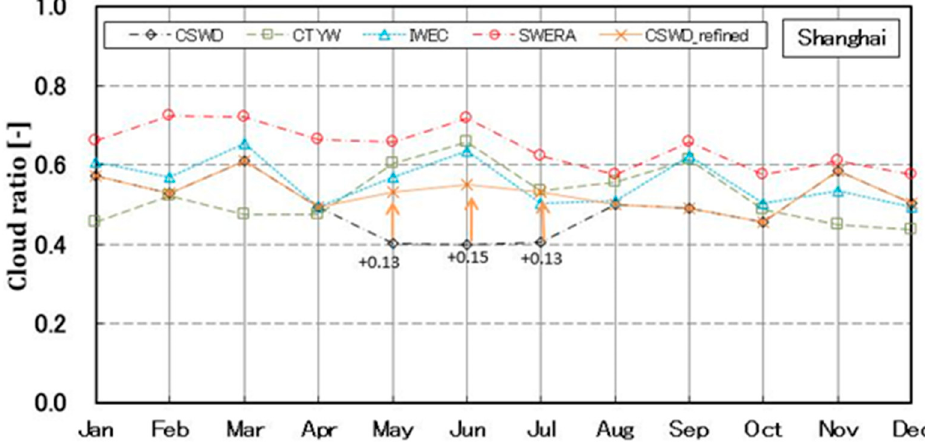
Figure 12. Refined monthly cloud ratios of the CSWD database in three months from May to July in Shanghai, China. Shanghai,